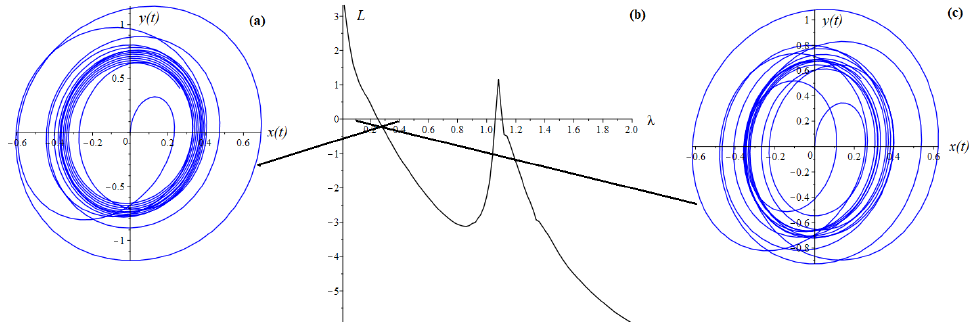
Figure 11. ( a ) Phase trajectories at λ = 0.1, ( b ) the spectrum of Lyapunov exponents from λ and ( c ) phase trajectories at λ = 0.4.